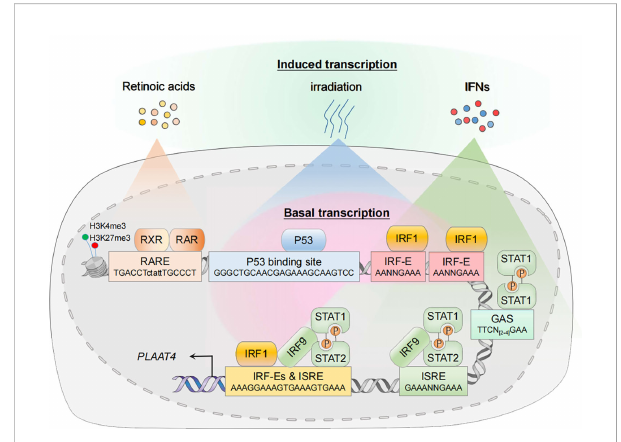
FIGURE 2 Transcriptional regulation of PLAAT4 . In the resting state, nuclear transcription factors p53 and IRF1 mediate constitutive expression of PLAAT4 . In the presence of agonists or acute stress, the corresponding signal transduction pathways are activated, thus leading to an enhanced PLAAT4 transcription. Epigenetic modi fi cations such as histone methylation also contribute to dynamic regulation of chromatin states, affecting binding of the RXR-RAR heterodimer and other transcription factors. RXR, retinoid X receptor; RAR, retinoic acid receptor; RARE, retinoic acid response element; p53-RE, p53 response element; IRF-E, IRF-binding element; ISRE, IFN-stimulated response element; GAS, gamma- activated